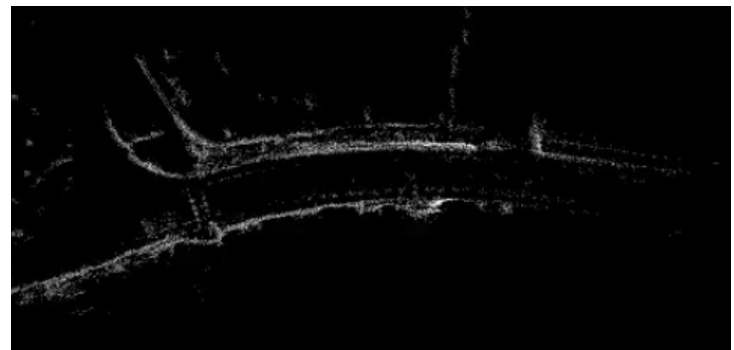
Figure 11. Map used for road edge